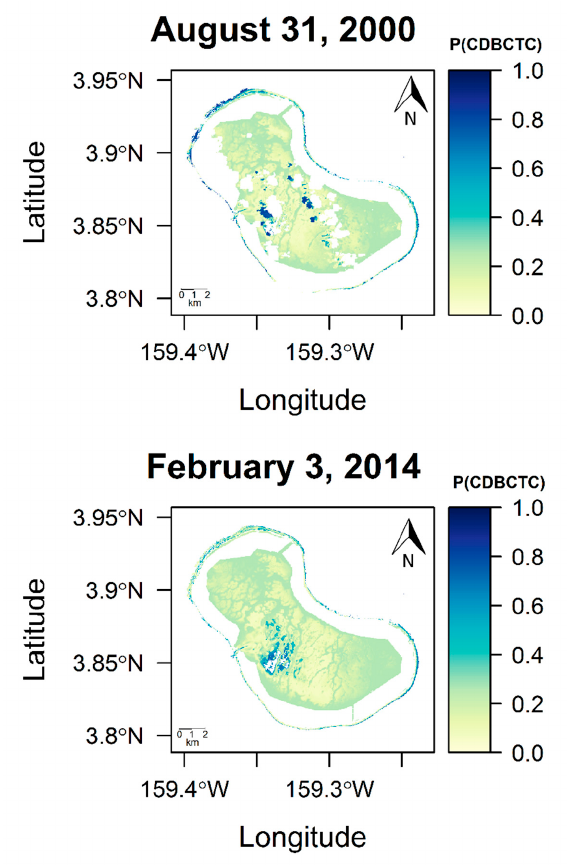
Figure 13. Posterior probability map for the Tabuaeran Island area of interest (top, 2000 and bottom, 2014).